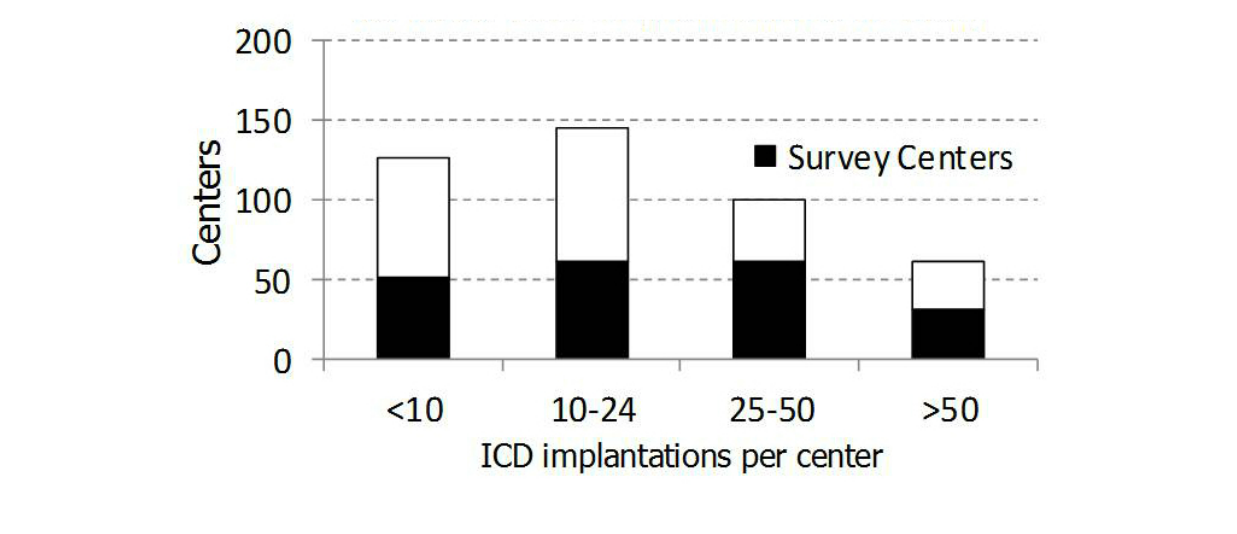
Figure 1. Volume of de novo implantations in the 432 Italian ICD implanting centers and the 206 Italia-RM survey centers in 2011 (published data from the national AIAC